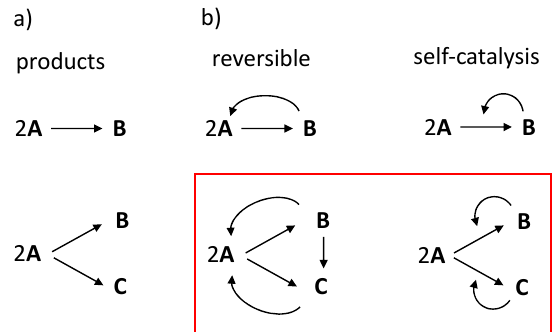
Figure 8. ( a ) Ordinary competitive chemical reactions 2 A → B and 2 A → C , and ( b ) reversible com- petitive chemical reactions B 2 A C involving self-catalytic chemical reactions 2 A + B → 2 B and 2 A + C → 2 C (red square), which are compared with chemical reaction 2 A → B .